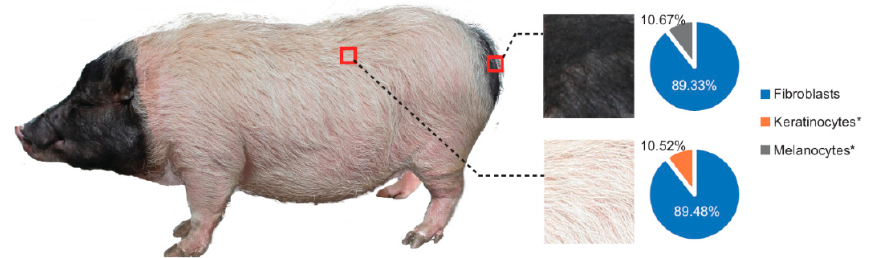
Figure 1. White and black skin were separately sampled from the pigs’ back and buttocks, and the pie plot shows the comparisons of fibroblast, keratinocyte and melanocyte in two different skins after evaluation by CIBERSORT [13]. Except for fibroblast, keratinocyte and melanocyte varied significantly between the two groups using the Student’s t -test (two-tailed). (*: p <